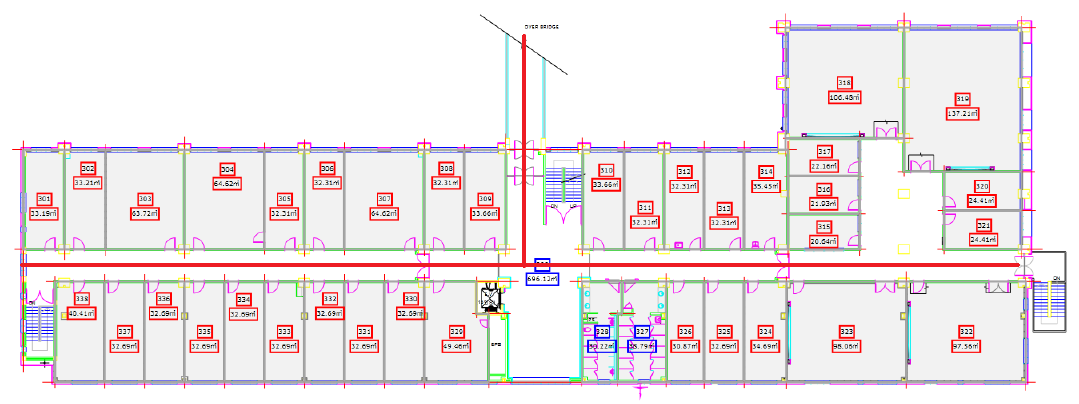
Figure 12. The test path on IT building floor